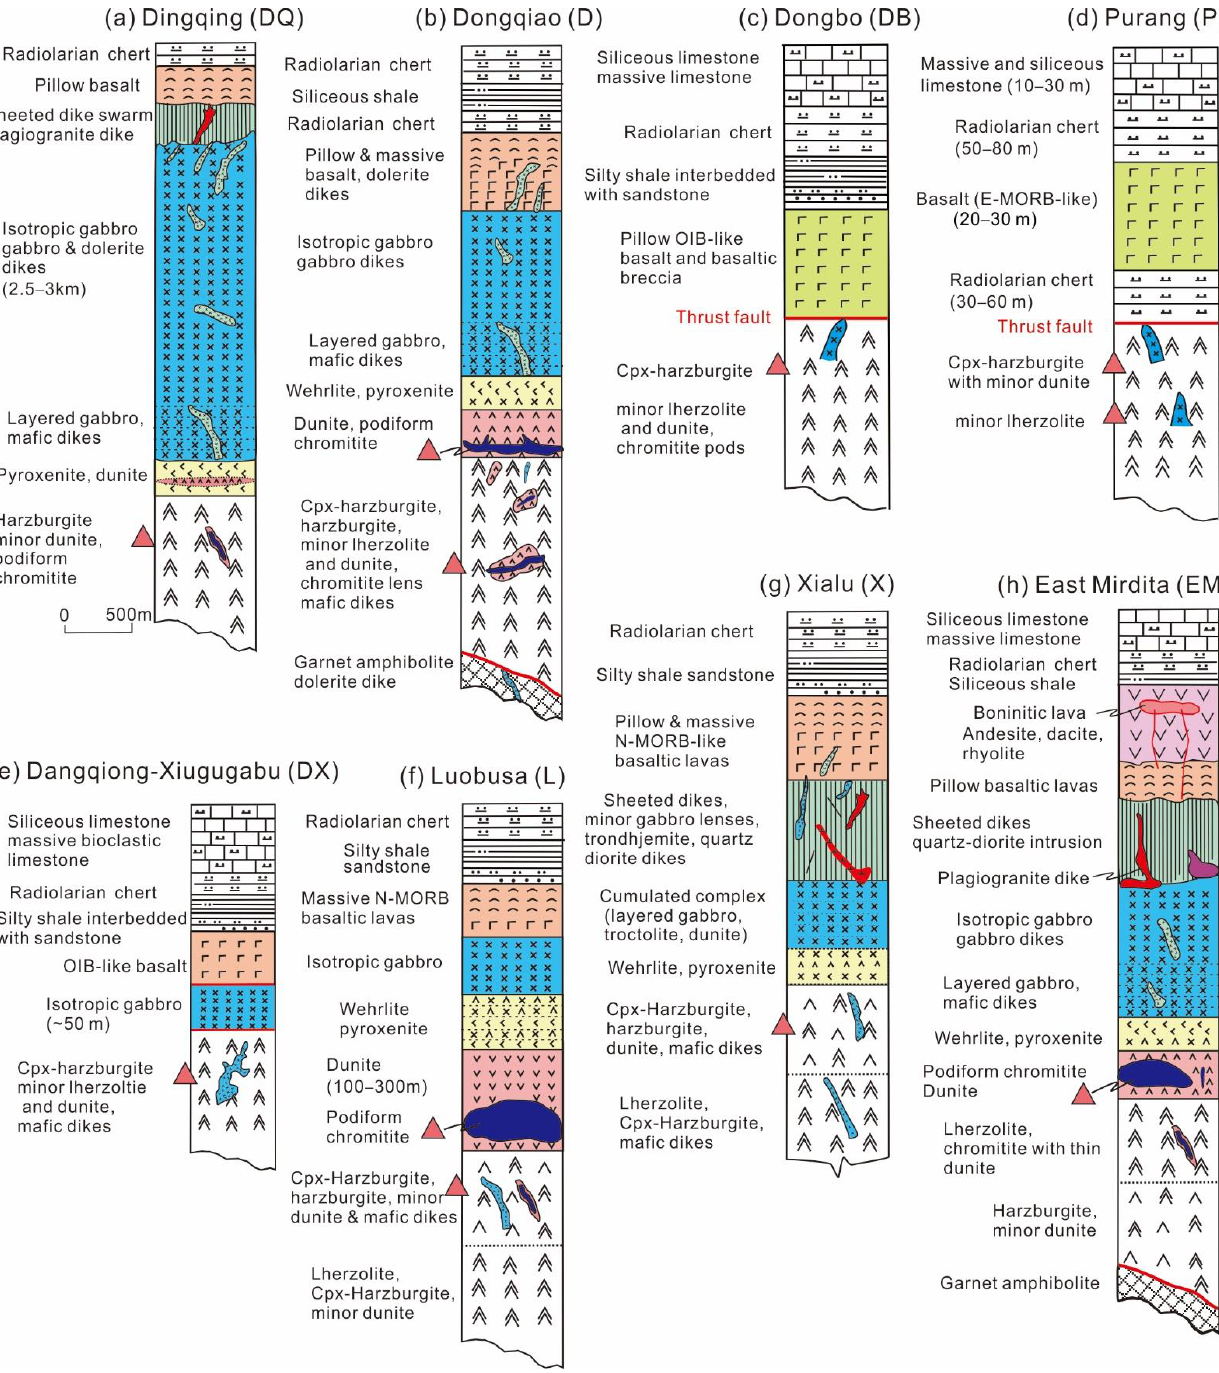
Figure 2. Compiled stratigraphic-lithological columnar sections of the main diamond-bearing ophiolites shown in Figure 1b along the Neotethyan Orogenic Belt. Red triangles labeled as diamonds hosted in podiform chromitite, harzburgite and lherzolite. ( a ) Dingqing ophiolite from the eastern part of the BNSZ, Tibet [27,44]; ( b ) Dongqiao ophiolite from the central part of the BNSZ, Tibet [13,14,44]; ( c ) Dongbo, ( d ) Purang and ( e ) Xiugugabu ophiolites from the wetern part of the IYSZ [44]; ( f ) Luobusa ophiolite from the eastern part of the IYSZ [14,16,17]; ( g ) Xialu ophiolite from the central part of the IYSZ [26,44]; ( h ) East Mirdita (Bulqiza massif) from the eastern Mediterranean ophiolite belt [28]. In a rock – melt interaction process, Re – Os isotopes can reflect the impacts of infil- trating melts on the ophiolitic mantle [66,67]. Os is a highly compatible element during